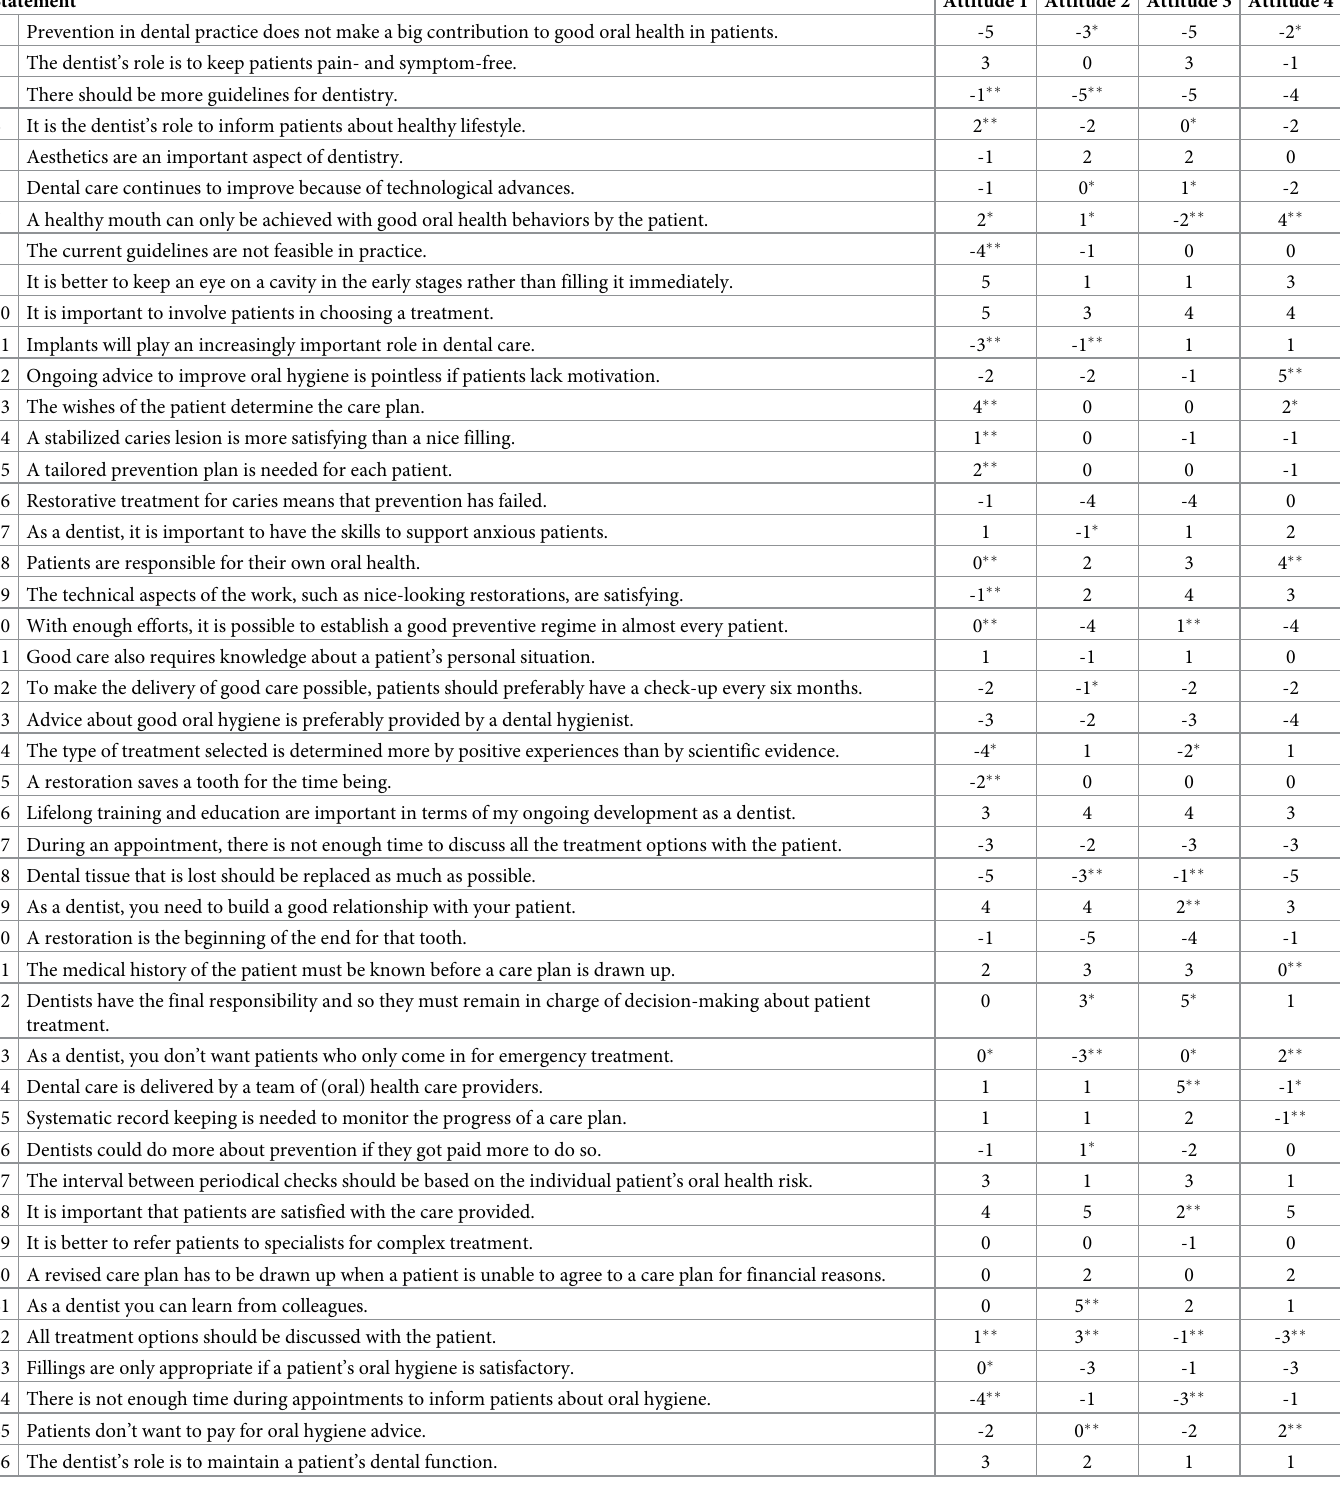
Table 2. Idealized sorting of the 50 statements for the full sample.